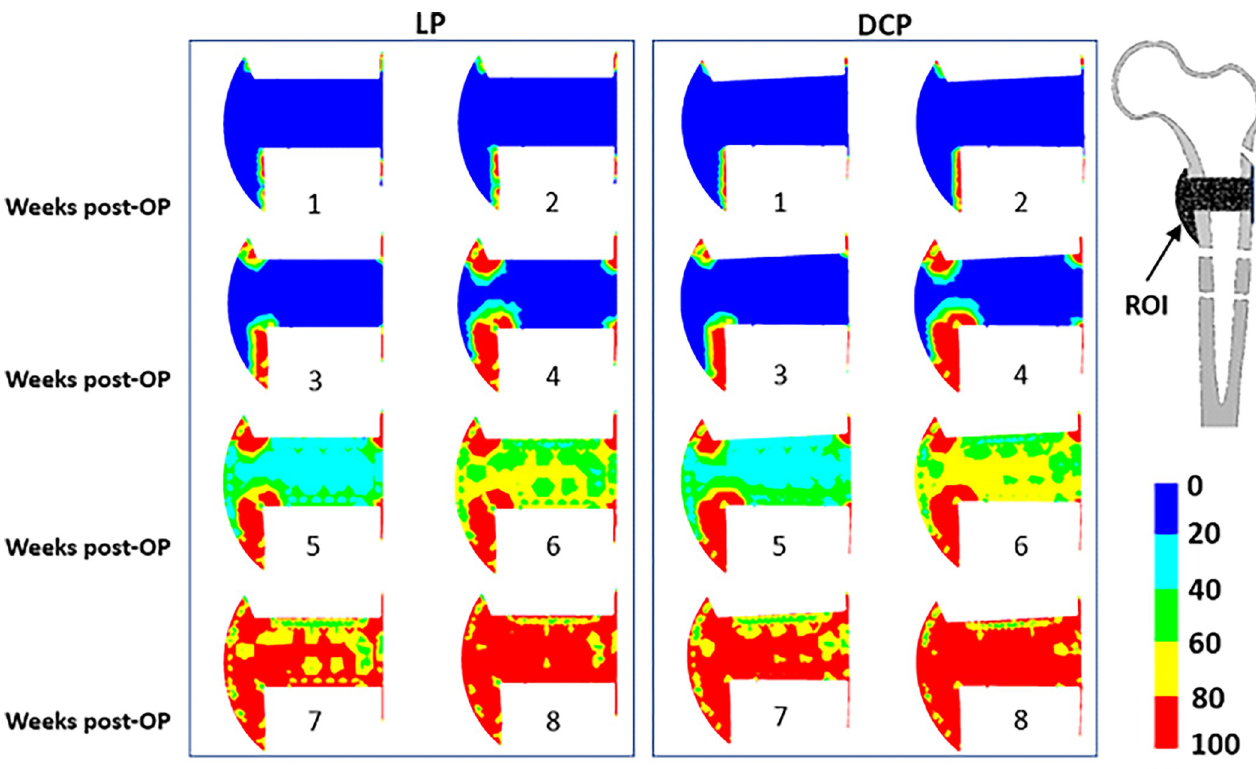
Fig 7. Post-operative distribution of percentage bone concentration in the ROI from week 1–8 for (a) LP and (b) DCP.